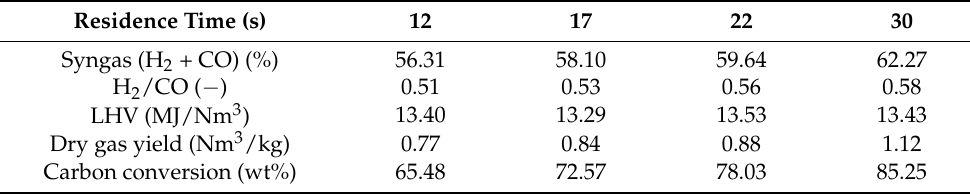
Table 1. Effect of residence time on properties of gas products. Residence Time